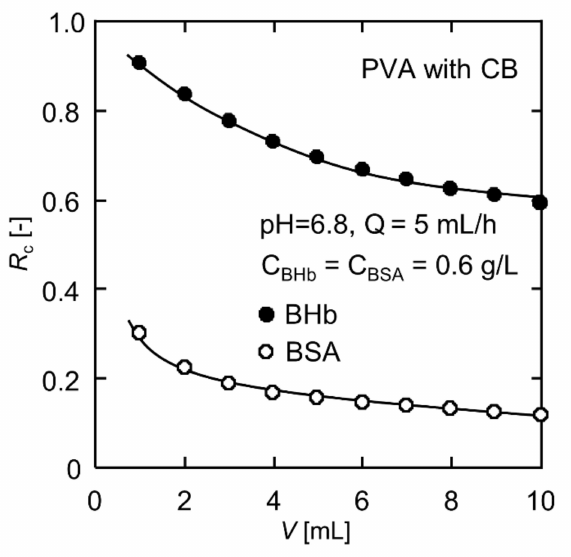
Figure 6. Selective separation results for the BHb–BSA binary